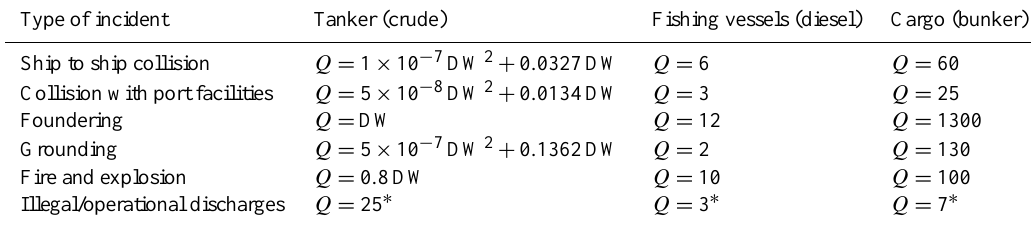
Table D2. Average amount of spilled oil per incident type and ship type.